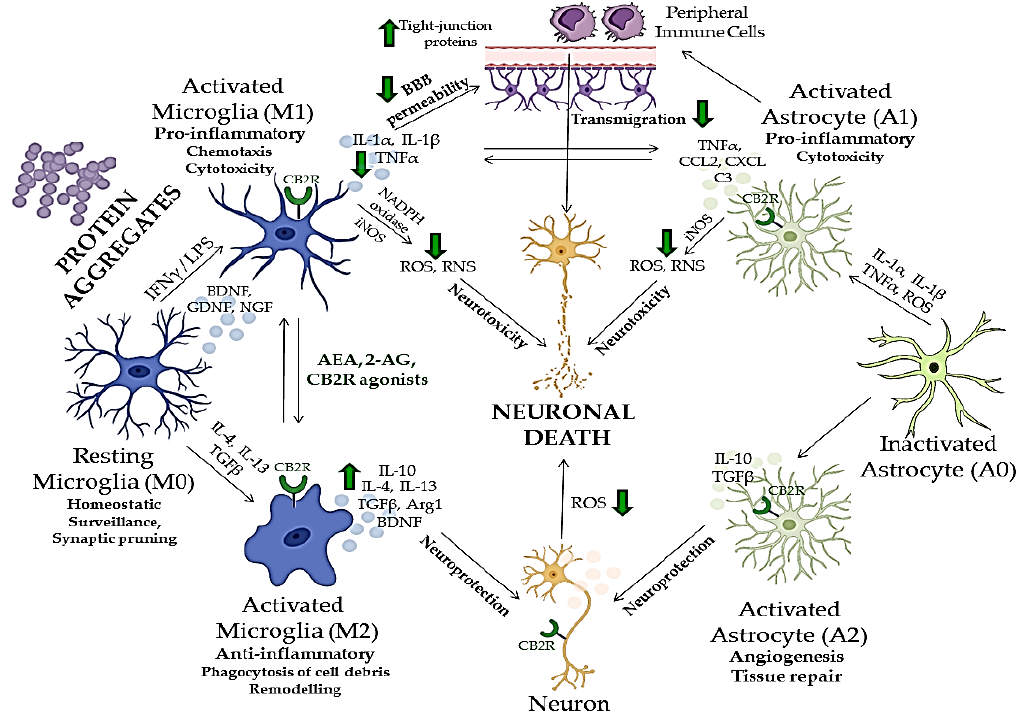
Figure 2. The cross-talk between neuroinflammation and neurodegeneration and neuroprotective effects of compounds acting via CB2R. Green arrows indicate the effects of endocannabinoids or CB2R agonists on different mediators of neuroinflammation and neurodegeneration. BBB — blood – brain barrier; CB2R — cannabinoid receptor 2; ROS — reactive oxygen species; RNS — reactive nitro- gen species; iNOS —inducible nitric oxide synthase; IFNγ— interferon gamma, LPS — lipopolysac-